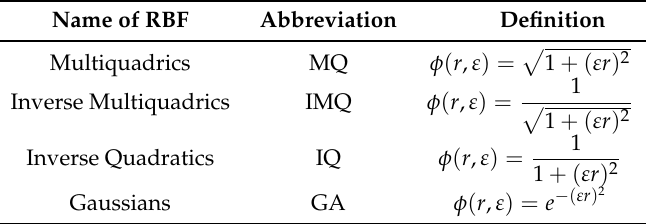
Table 1. Radial basis